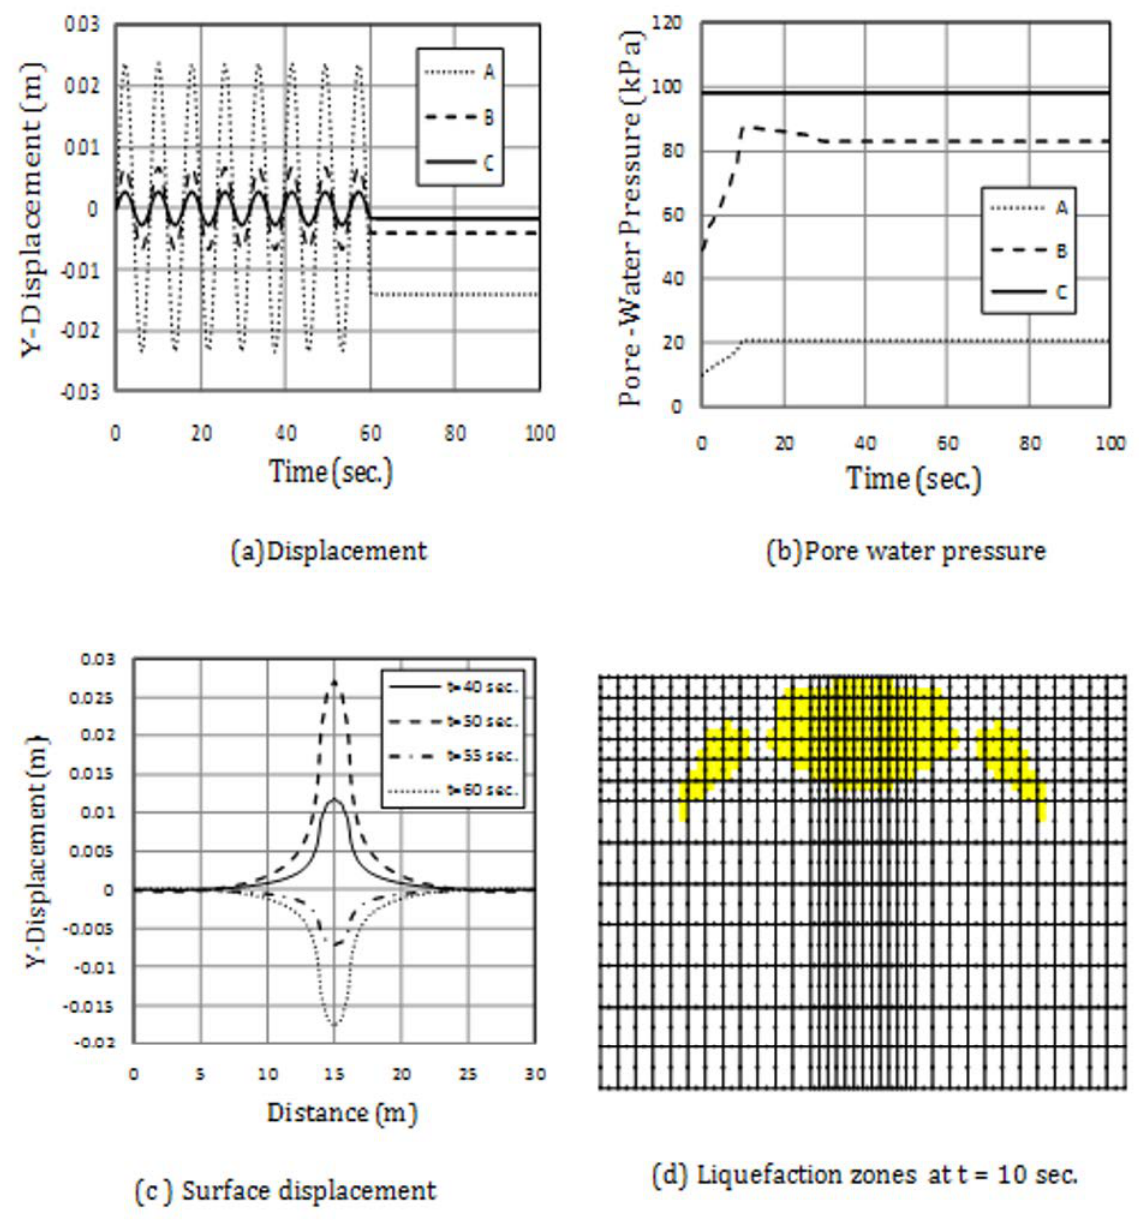
Figure 21. Dynamic response of the foundation to harmonic load, a